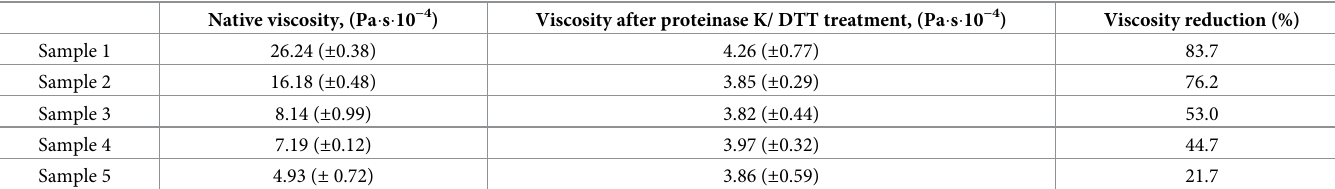
Table 1. Viscosity of saliva samples with and without proteinase K / DTT treatment.